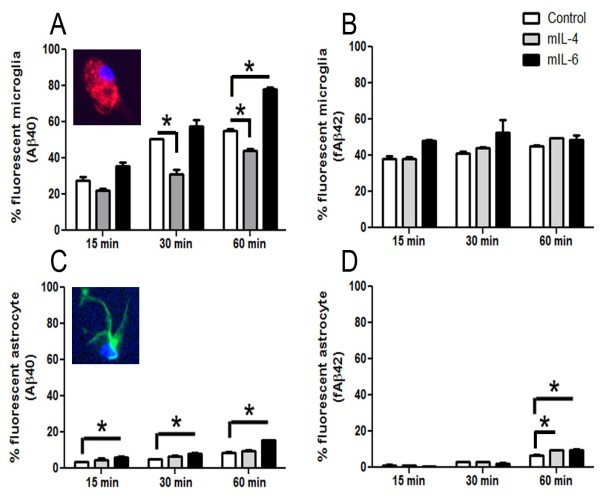
Differential effect of cytokines on Aβ40 and fAβ42 uptake by primary mouse glia and astrocytes. A-B. mIL-4 treatment decreases microglial uptake of Aβ40 (A) but does not affect fAβ42 uptake (B). mIL-6 increased microglial Aβ40 uptake (A) but does not significantly alter fAβ42 uptake (B). Primary mouse glia were treated with recombinant cytokines for 10 hrs and incubated with Aβ40-Hilyte555 or Aβ42-Hilyte555 for 15 min, 30 min and 60 min. Trypsinized cells were counted using Accuri6 flow cytometer. Unstained cells and labeled additives were excluded by gating to yield the percentage of fluorescent cells in the mix. Inset depicts cd11b/DAPI stained glia (A) Results are representative of three independent experiments. (*p < 0.05, One way Anova with Tukey’s post test). Data represents mean ± sem. C-D. mIL-4 treatment does not affect astrocytic uptake of Aβ40 (C) but increases fAβ42 uptake after 60 min incubation (D). mIL-6 consistently increases astrocytic Aβ40 uptake (C) and only enhances fAβ42 uptake after 60 min incubation (D). Primary mouse astrocytes were treated with recombinant cytokines for 10 hrs and incubated in Aβ40-Hilyte555 or Aβ42-Hilyte555 for 15 min, 30 min and 60 min. Trypsinized cells were counted using Accuri6 flow cytometer. Unstained cells and labeled additives were excluded by gating to yield the percentage of fluorescent cells. Inset depicts GFAP/DAPI labeled astrocyte (C). Results are representative of two independent experiments. (*p < 0.05, One way Anova with Tukey’s post test). Data represents mean ± sem.